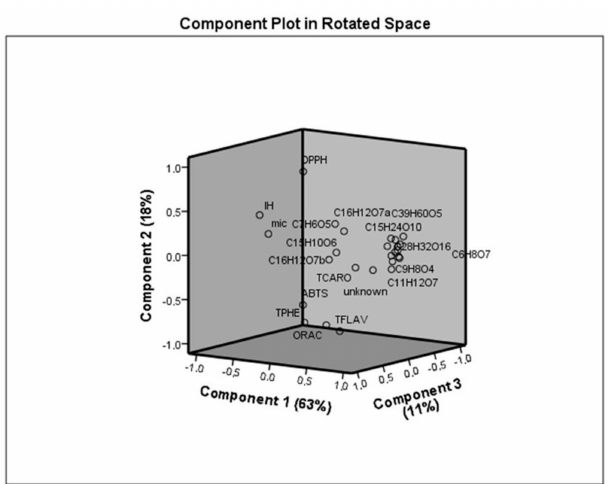
Figure 3. Principal component analysis (PCA) of data, where ABTS, DPPH, ORAC, TFLAV, TPHE, TCARO, IH, and MIC mean total antioxidant activity measured by ABTS, DPPH, and ORAC meth- ods, total flavonoids, total phenolics, total carotenoids, inhibition halos, and minimum inhibitory concentration, respectively. Individual compounds are identified by their chemical